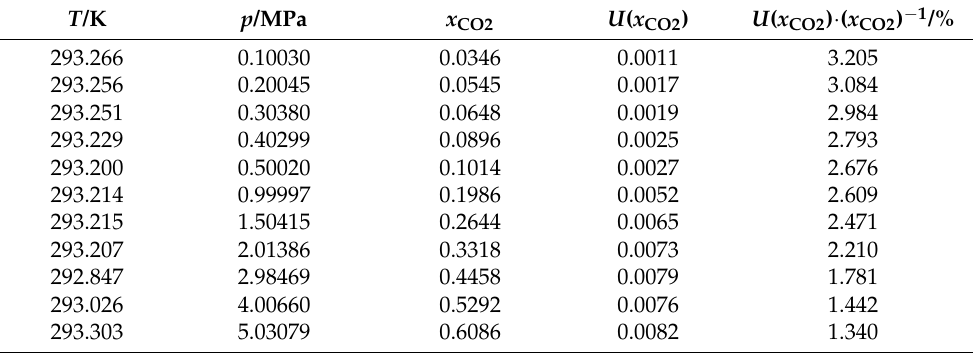
Table A5. Experimental results for solubility measurements of pure carbon dioxide in [Bmim][PF 6 ] at T = 293.15 K using Raman spectroscopy. Recorded temperature (ITS-90), pressure, mol fraction, and estimated uncertainties ( k = 2) are listed in the